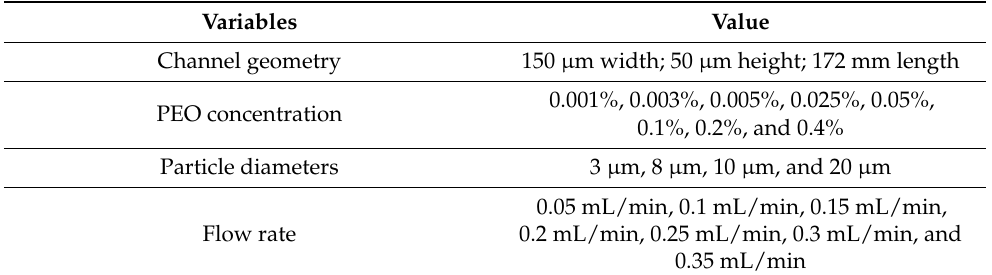
Table 1. Summary of experiment parameters in the spiral channel particle separation